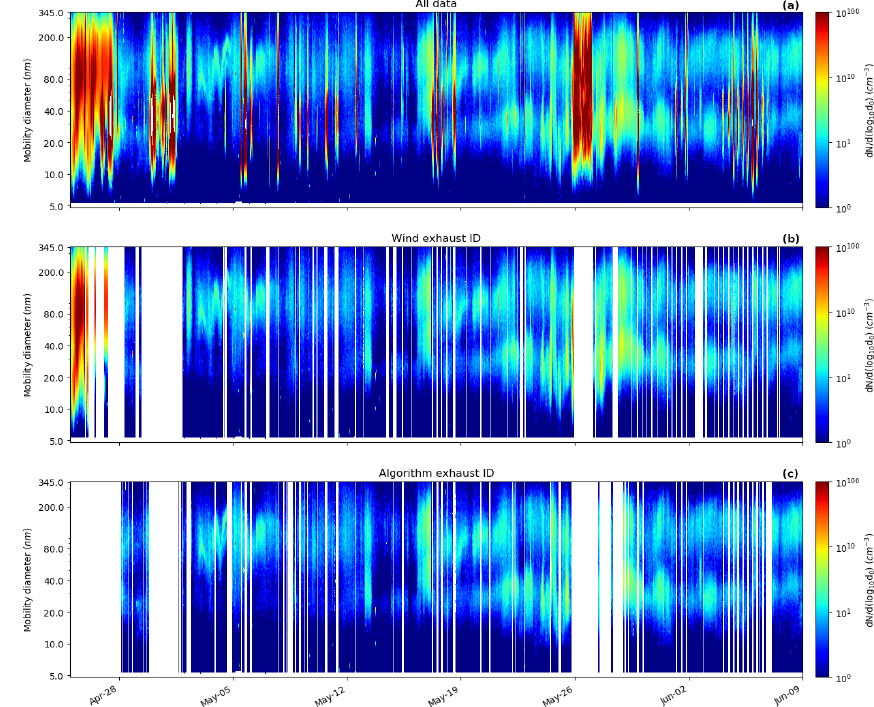
Figure A11. Aerosol size distributions measured using a GRIMM SMPS with M-DMA installed. Panel (a) shows all raw data recorded, while the wind-based filter and the exhaust algorithm are applied to the two subsequent graphs (b, c) respectively, removing periods identified as sampling